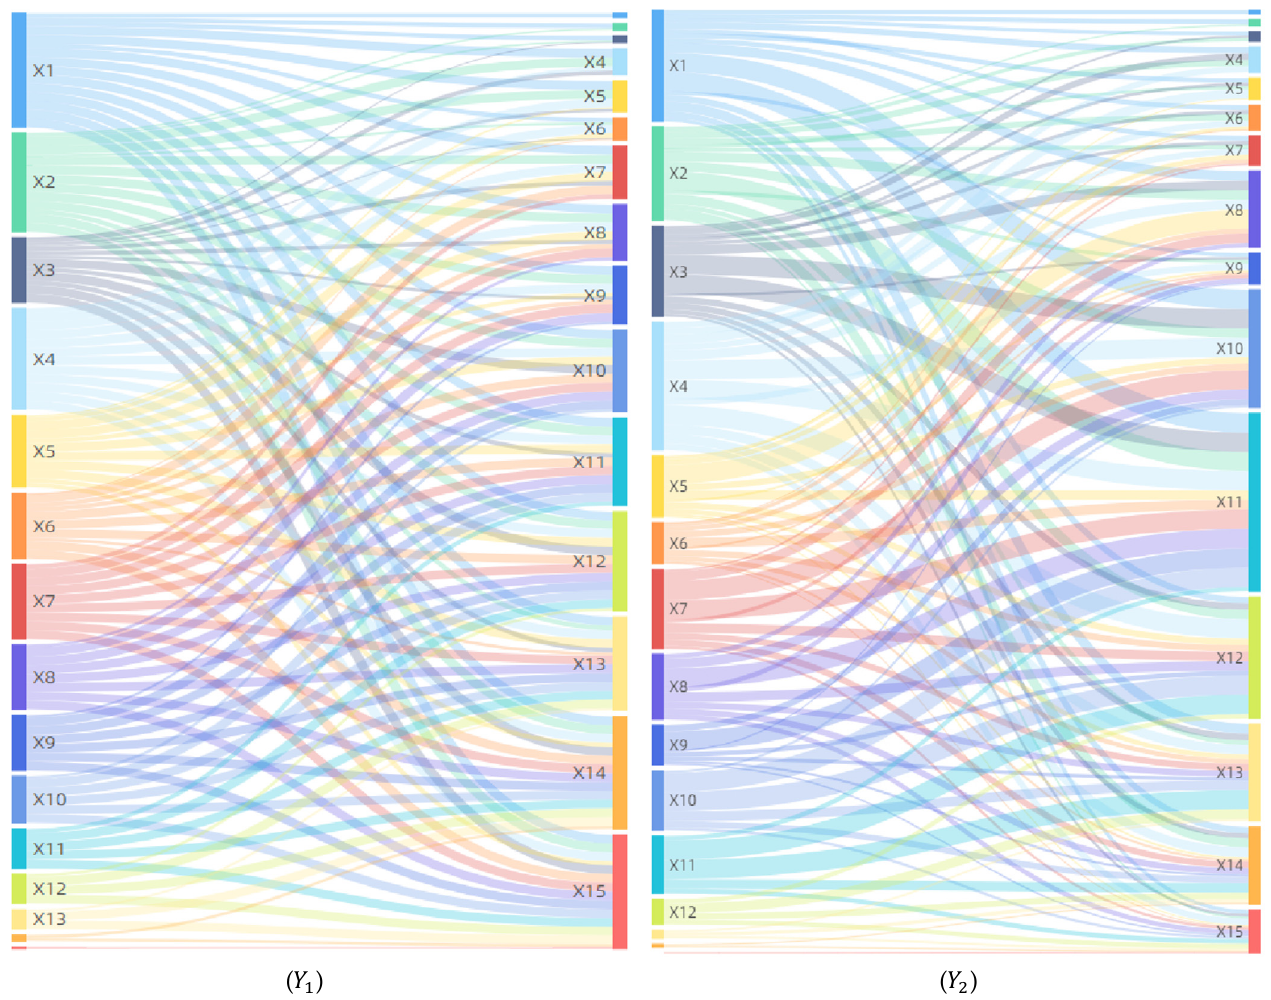
Figure 7. Analysis of interaction detector . ( Y 1 ), ( Y 2 ):Number of Patients and Deaths